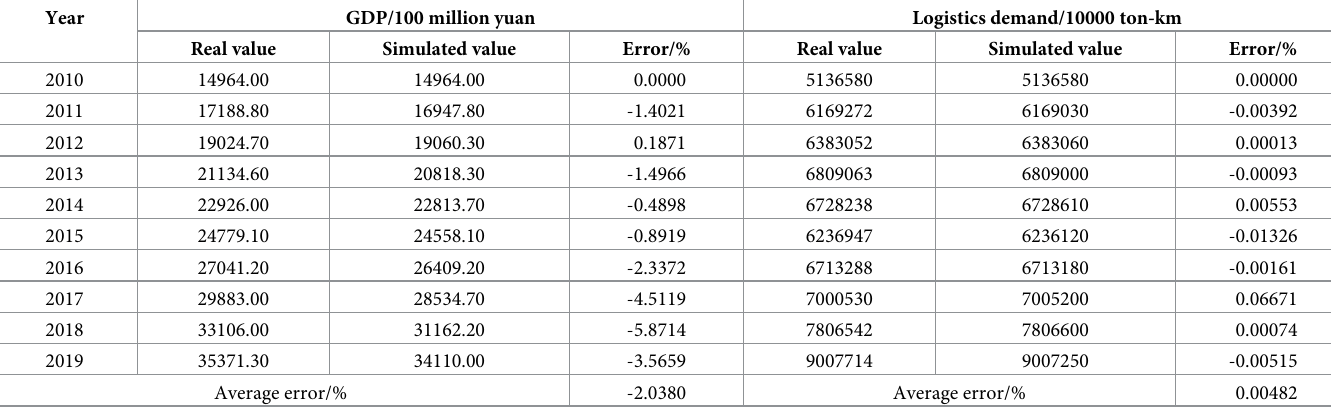
Table 6. Results of the historical and simulated